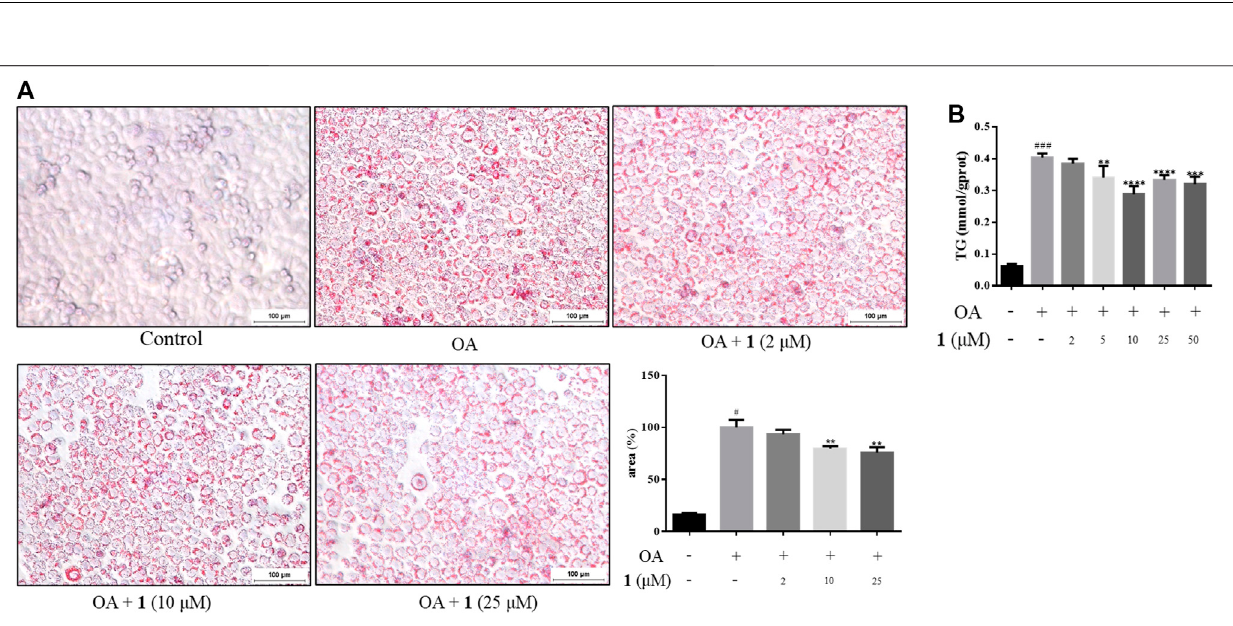
Frontiers in Pharmacology |